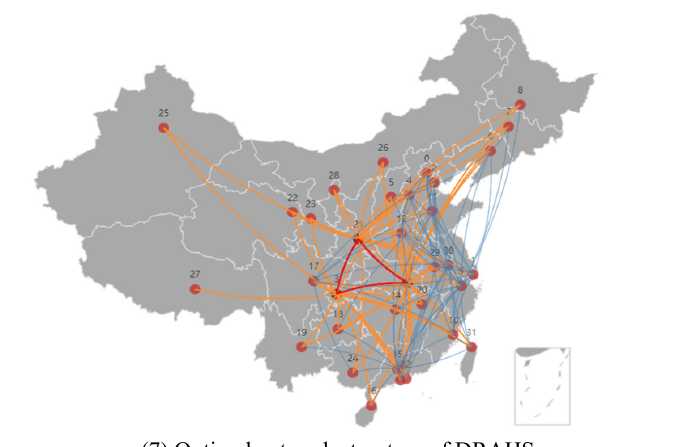
Fig. 4. The optimal network structure of ETN under different topologies